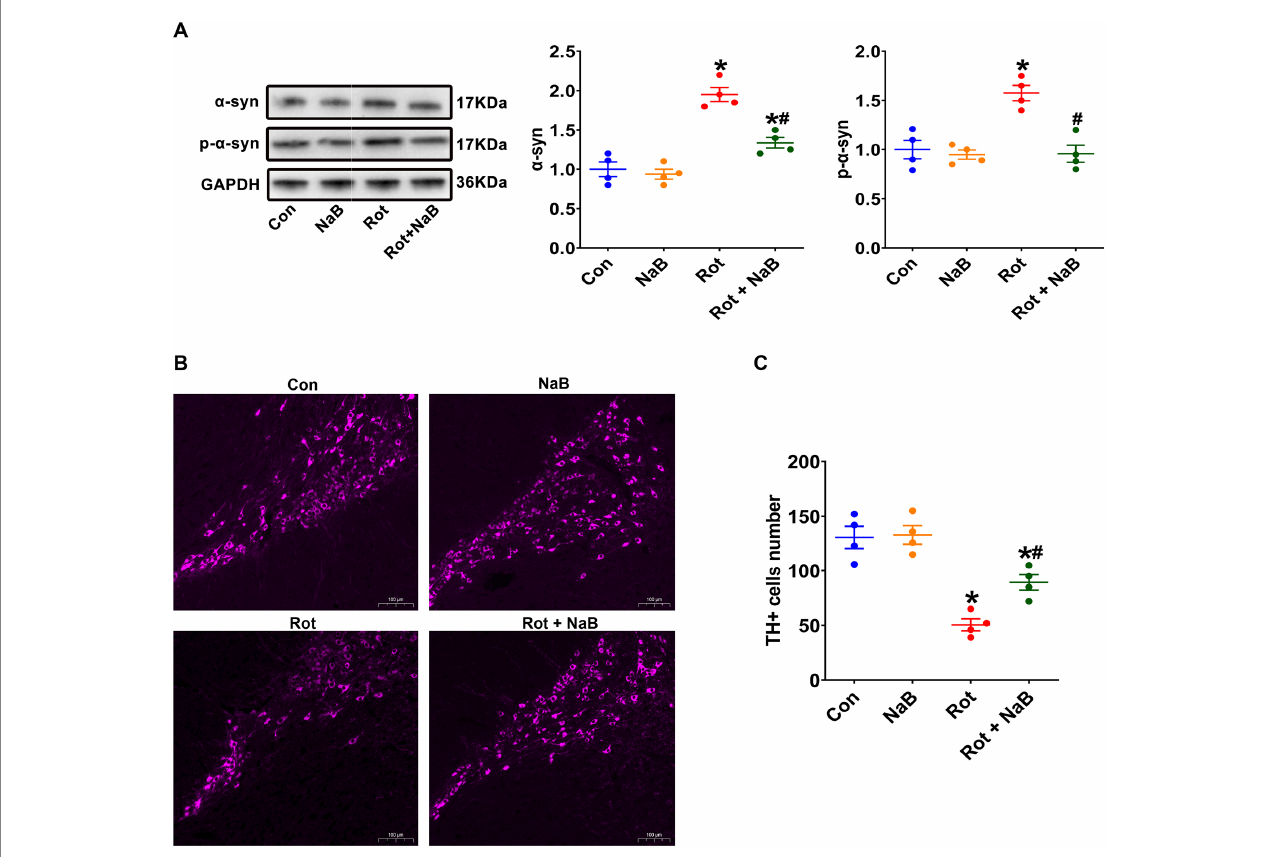
FIGURE 3 NaB alleviates rotenone-induced substantia nigra α -synuclein pathology. (A) Representative blots of α -syn and p- α -syn expression in substantia nigra. (B) Representative photomicrographs of substantia nigra sections immunostained for TH. Scale bar = 100 μ m. (C) Quantitative analysis of the TH positive cells numbers. n = 4 per group. The data represent the mean ± SEM. * p < 0.05 vs. Con group; # p < 0.05 vs. Rot group. α -syn: α -synuclein; Con: control; NaB: sodium butyrate; p- α -syn: phospho-Ser129 α -synuclein; Rot: rotenone; TH: tyrosine